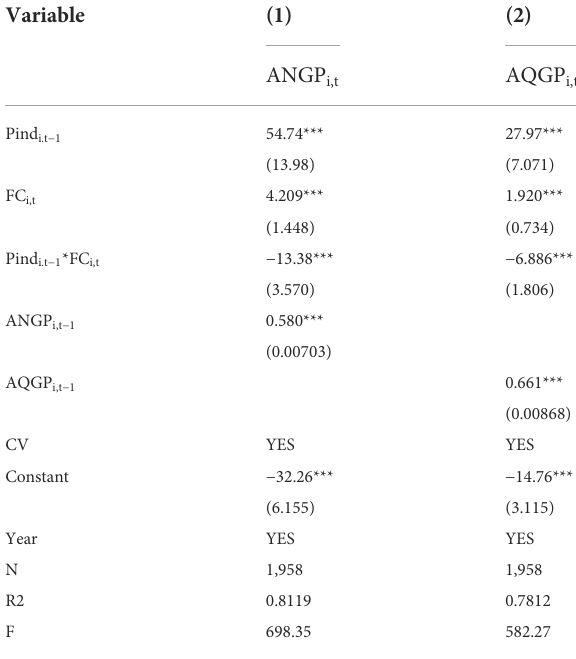
TABLE 10 Test results for the moderating effect of fi nancing